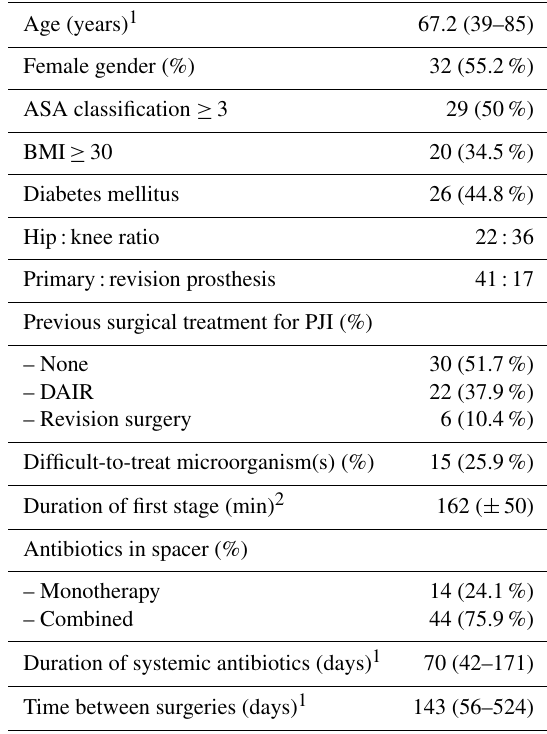
Table 2. Microorganisms isolated in the first stage of the 58 patients